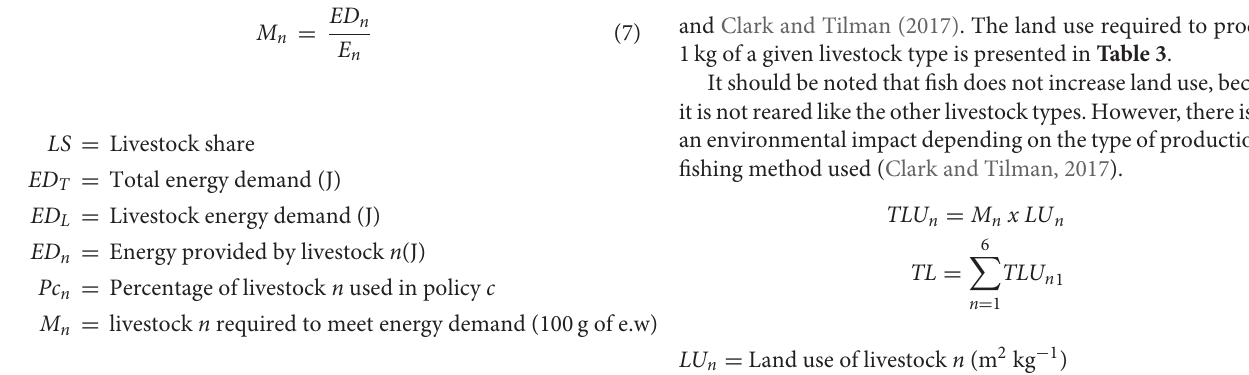
Frontiers in Sustainable Food Systems |